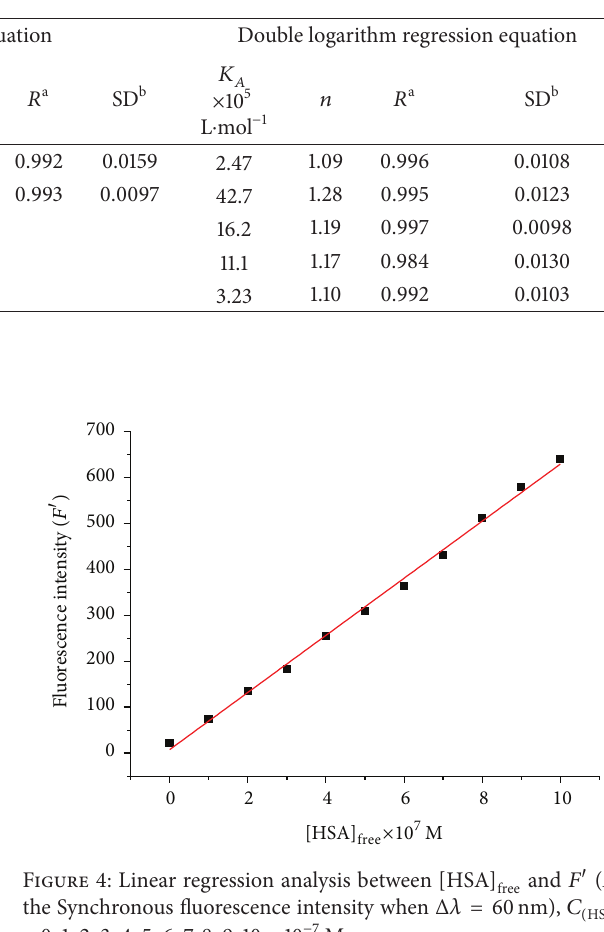
and 𝐹 󸀠 ( 𝐹 󸀠 free HSA )